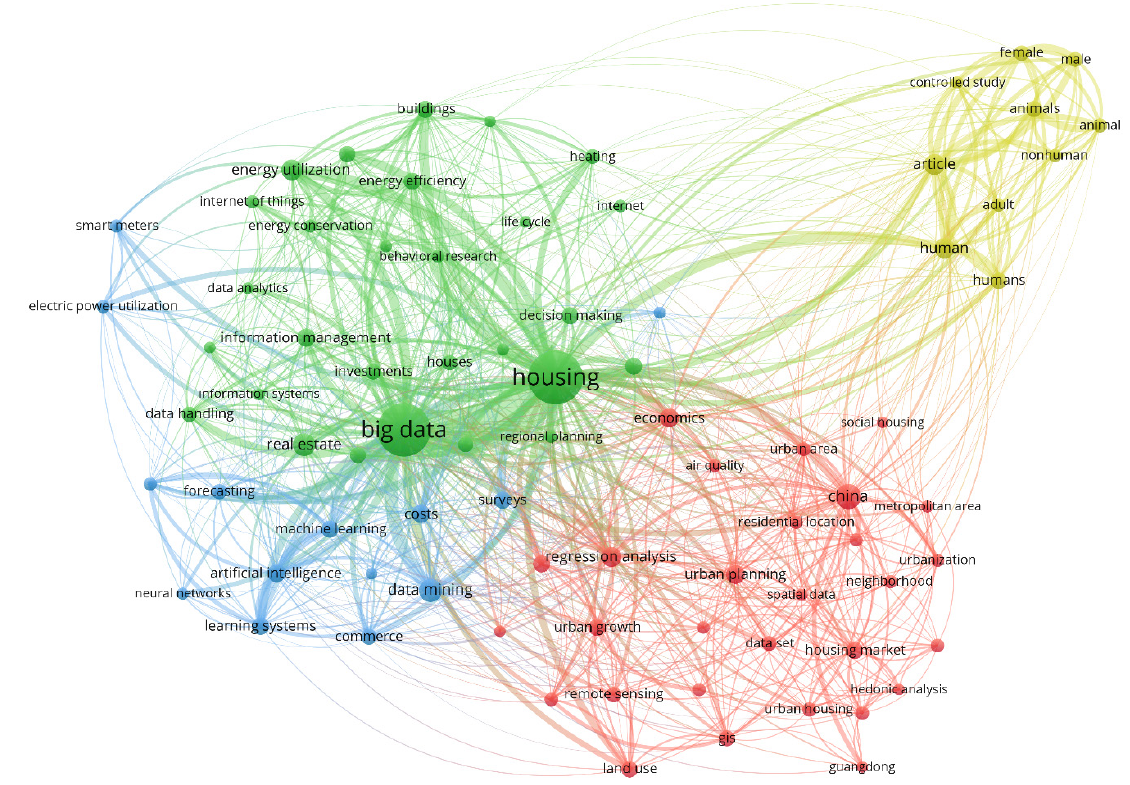
Figure 3. Most frequent keywords used in the big data articles on real estate and property from 2010 to 2020.